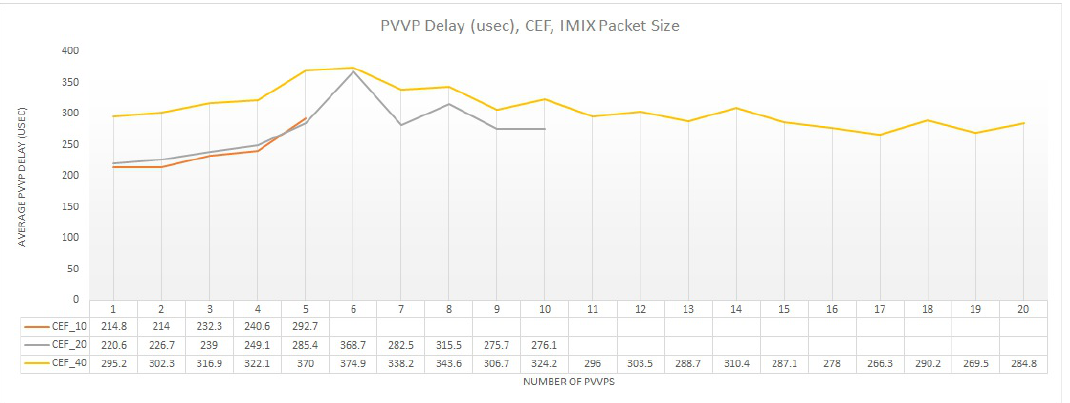
Figure 15. Single-Feature multi-PVVP average delay with